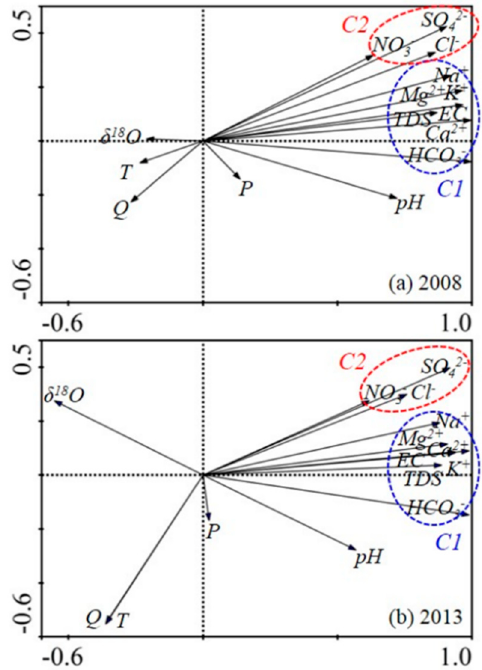
Figure 10. Principle component analysis (PCA) for species in river water at the Hailuogou basin over two melt seasons in 2008 ( a ) and 2013 ( b ). Variables are ions, δ 18 O, pH, electrical conductivity (EC), total dissolved solids (TDS), air temperature (T), precipitation (P) and discharge (Q). The similar arrow direction indicates that variables exhibit a positive correlation, the opposite direction indicates a negative correlation, and the perpendicular direction denotes no correlation.